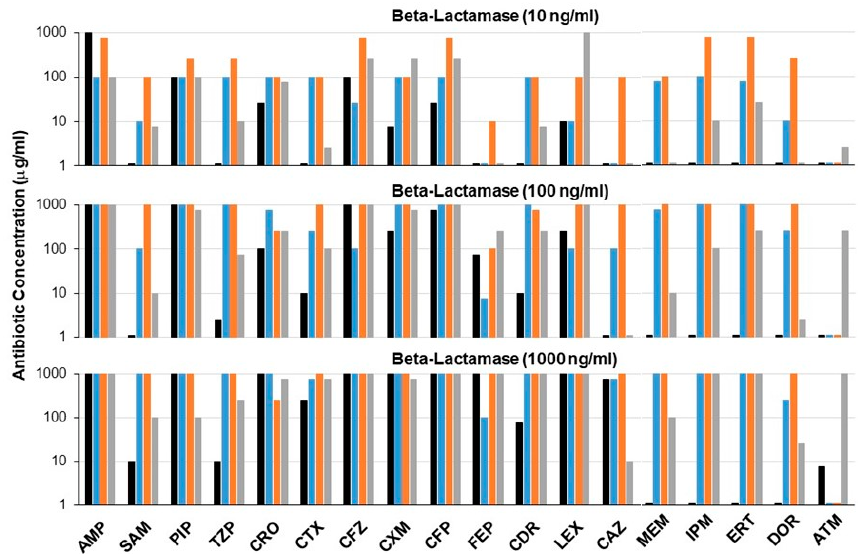
Figure 1. Antibiotic degradation profiles of beta ‐ lactamase enzymes. Antibiotic degradation was assessed using an E. coli growth assay. Purified beta ‐ lactamases (10, 100, or 1000 ng/mL) were added to wells of a microtiter plate containing high antibiotic concentrations (10, 100, or 1000 μ g/mL) after which E. coli were added immediately. Bacterial growth, an indication of antibiotic inactivation, was measured the next day (OD625). The data represent the highest concentration of antibiotic that was inactivated by the beta ‐ lactamase. Ribaxamase: black, P2A: blue, New Delhi metallo ‐ beta ‐ lactamase